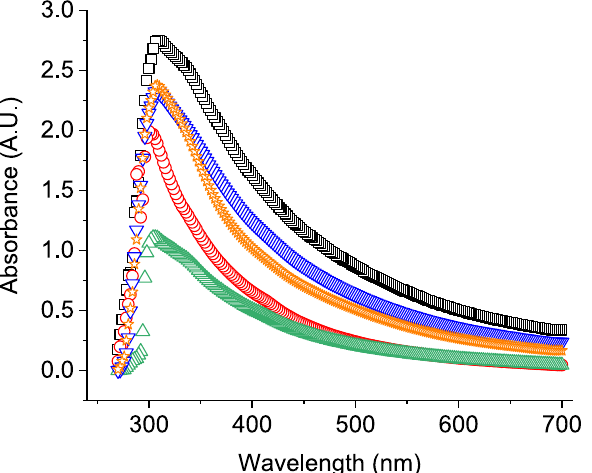
Figure 2. UV–visible absorption spectra of tyrosinase in buffer ( □ , black) and ink solutions made with glycerol ( ○ , red), carboxymethyl cellulose ( ∇ , blue), polyethylene glycol (Δ, green) and polyvinyl alcohol ( ☆ , orange) as viscosity modifiers.